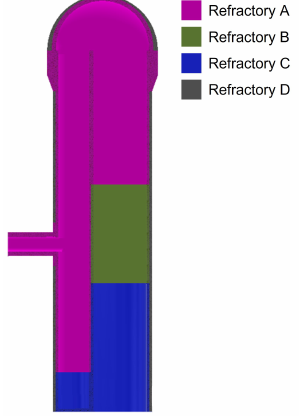
Figure 5. Types of refractories applied to the hot blast stove. Table 3. Material properties of the refractory